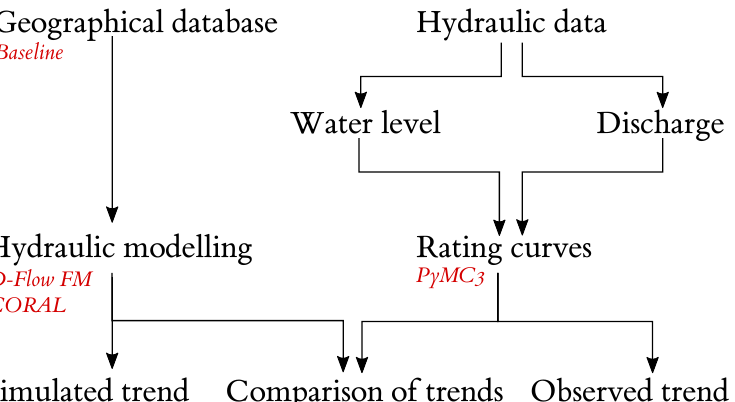
Figure 2. Schematic outline of the methodology. The software used is indicated with red, italicised